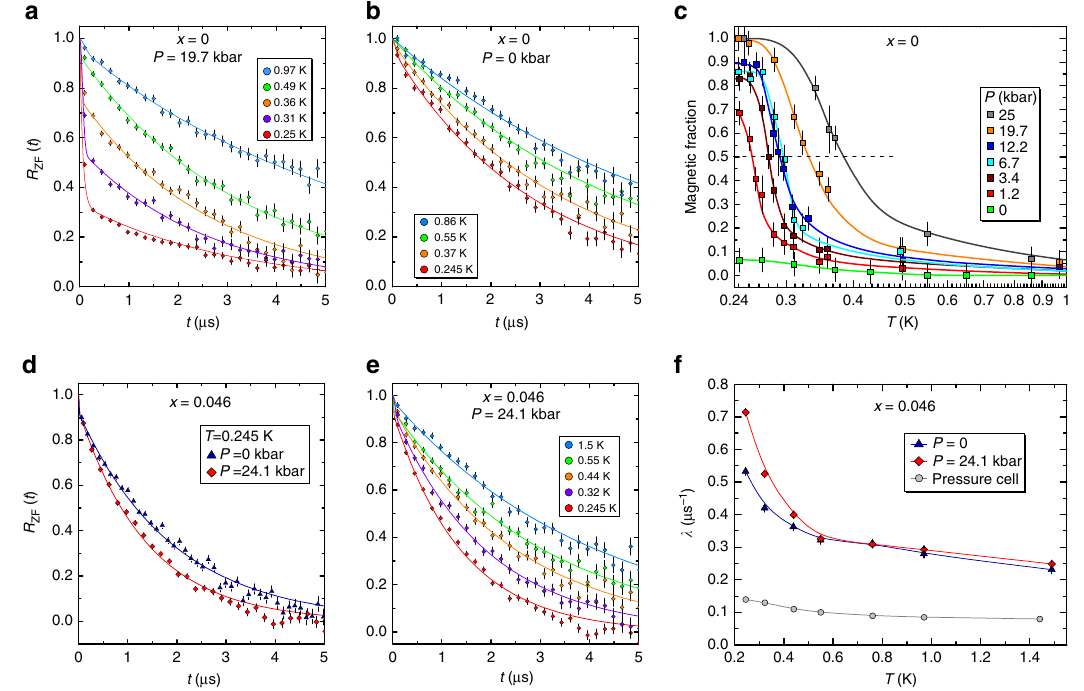
Figure 2 | Temperature evolution of the l SR relaxation in Yb 2 þ x Ti 2 (cid:2) x O 7 þ d under pressure. ( a – c ) Refer to the x ¼ 0 and ( d – f ) refer to the x ¼ 0.046 sample. ( a ) The drastic increase of relaxation observed upon decreasing temperature in the x ¼ 0 sample indicates a spin freezing under an applied pressure P ¼ 19.7kbar, which is absent under zero pressure ( b ) and for the x ¼ 0.046 sample ( d ). ( c ) The temperature evolution of the magnetic fraction is reported for various pressures. The black horizontal dashed line represents a volume magnetic fraction of 50%, used as a criterion to define T c . ( e , f ) For the x ¼ 0.046 sample, only a moderate increase of the spin dynamics is observed under applied pressure. The error bars of the m SR relaxation data are of statistical origin and correspond to the square root of the total number of detected positrons resulting from muon decays. Error bars of the relaxation rate l represent standard deviation of the fit parameters. Error bars of the magnetic fraction represent standard deviation of the fit parameters, with a minimal value of 0.05 corresponding to the typical error on the total asymmetry for m SR under pressure.